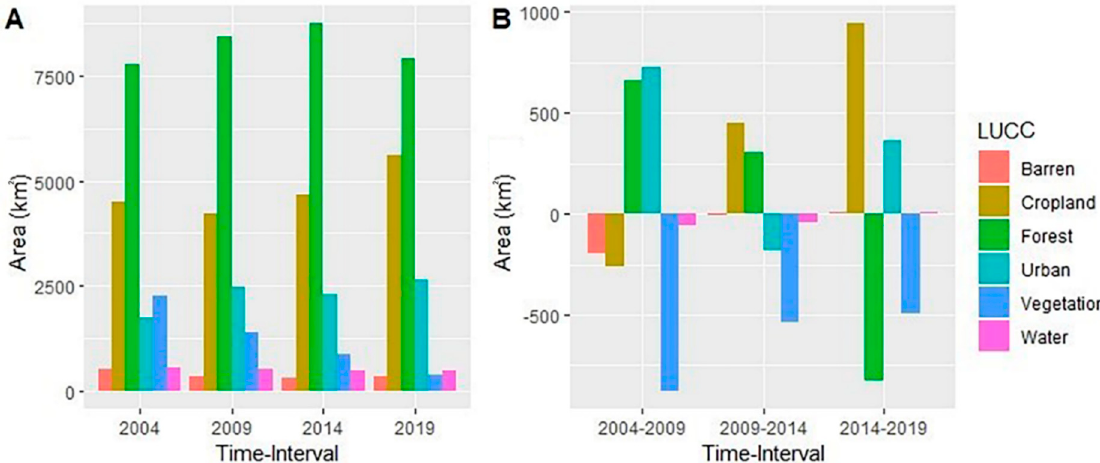
Figure 4. The portion of land use/land cover changes (LUCC), ( A ) represent the relative proportion (km 2 ) of various classes of land use cover (LUC) in Beijing during the years of 2004, 2009, 2014 and 2019. ( B ) shows the cumulative changes in various land use categories between the three periods of 2004–2009, 2009–2014, and